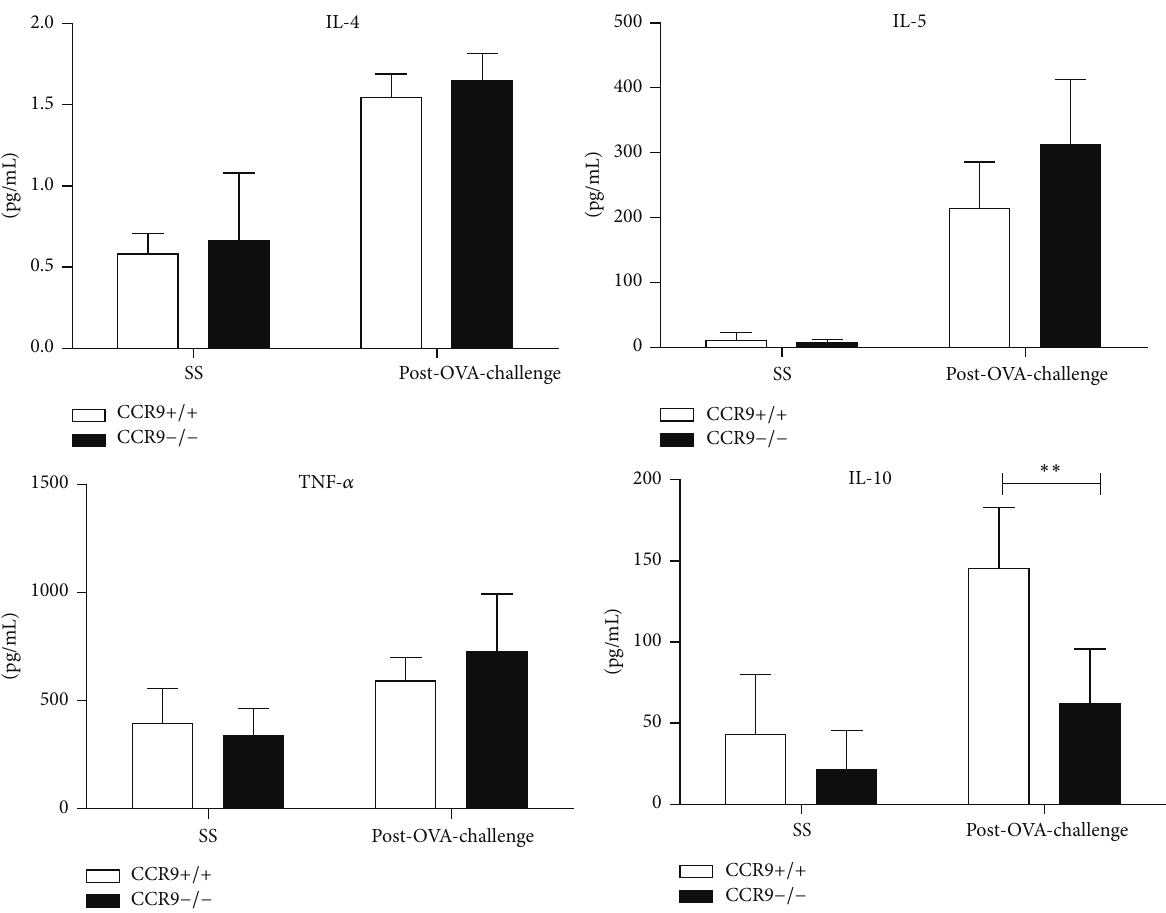
Figure 3: Absence of CCR9 decreases IL-10 production in BALF. BALF cytokines were quantified by ELISA. Levels of IL-4, Il-5, TNF- 𝛼 , and IL-10 represented as mean ± SD. 𝑛 = 4 ( ∗∗ 𝑝 < 0.01 when compared with WT mice or when compared each time with control